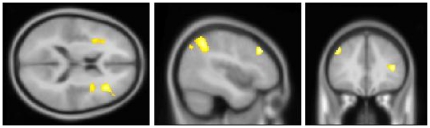
Overall contrast of stimulation versus neutral baseline.One-third of trials were cold, 1/3 warm, and 1/3 TGI. The anterior insula was activated bilaterally along with bilateral fronto-parietal areas. Crosshair position: x = −43 mm, y = 33 mm, z = 16 mm. See also Table 1.